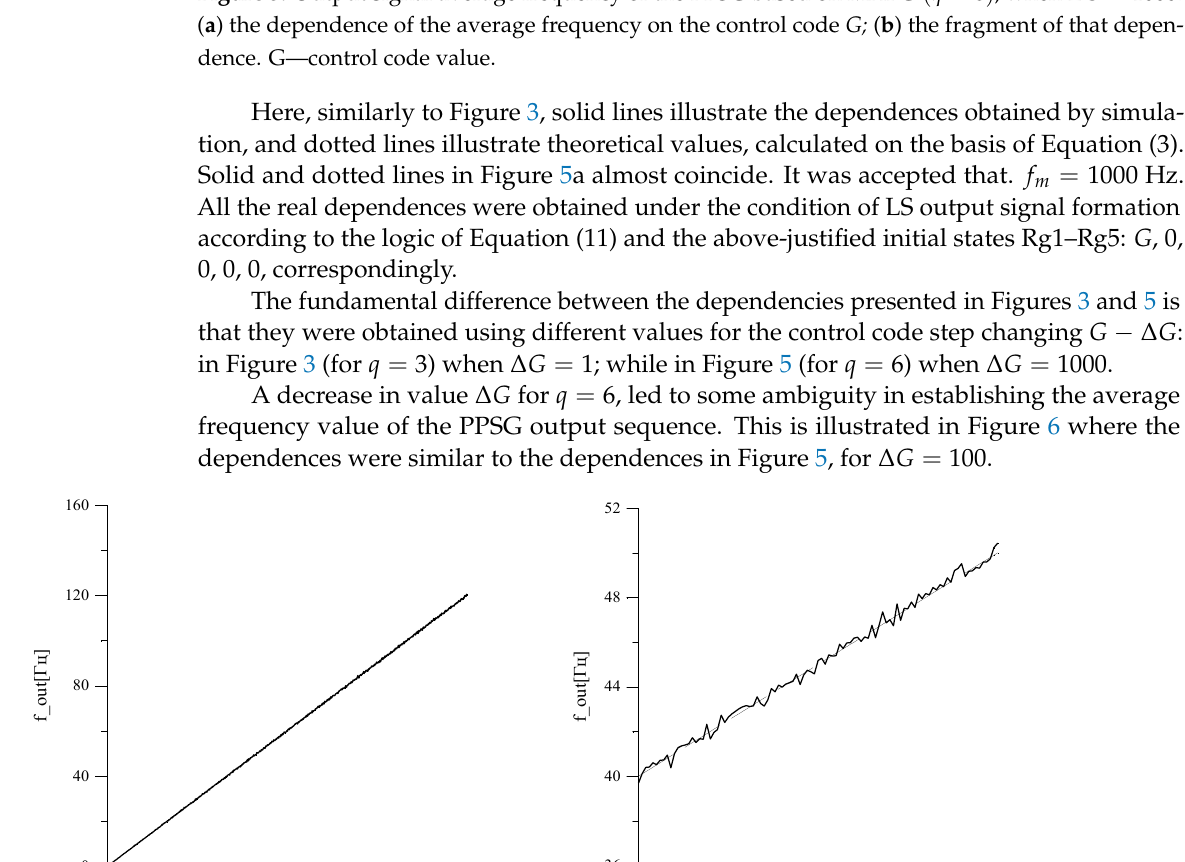
( ) 6 = q , when 100 Δ = G